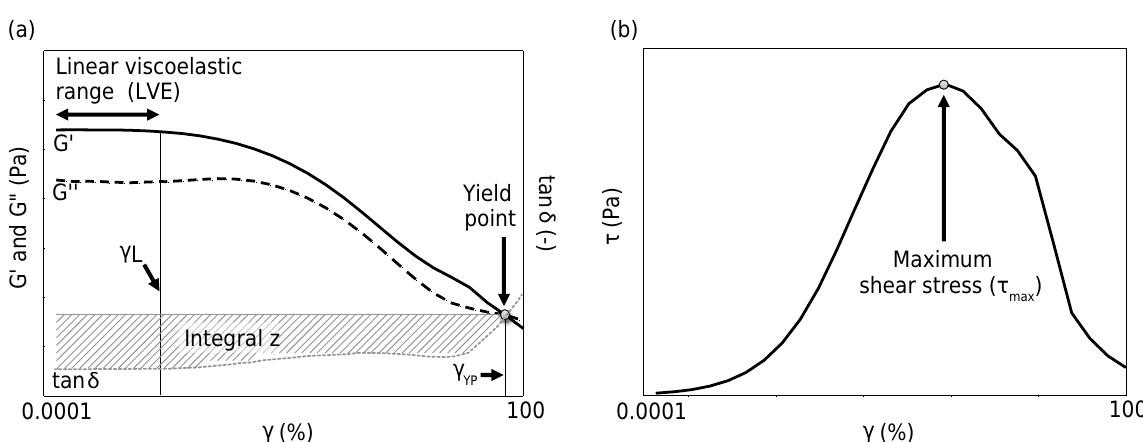
Figure 1. Representative illustration of information obtained from the amplitude sweep test: storage modulus (G’), loss modulus (G”), and loss factor (tan δ) versus deformation (γ), plotted on a logarithmic scale (a), and shear stress (τ) versus deformation (γ) (b). Source: adapted from Horn and Peth (2011) (a) and Holthusen et al. (2012b)